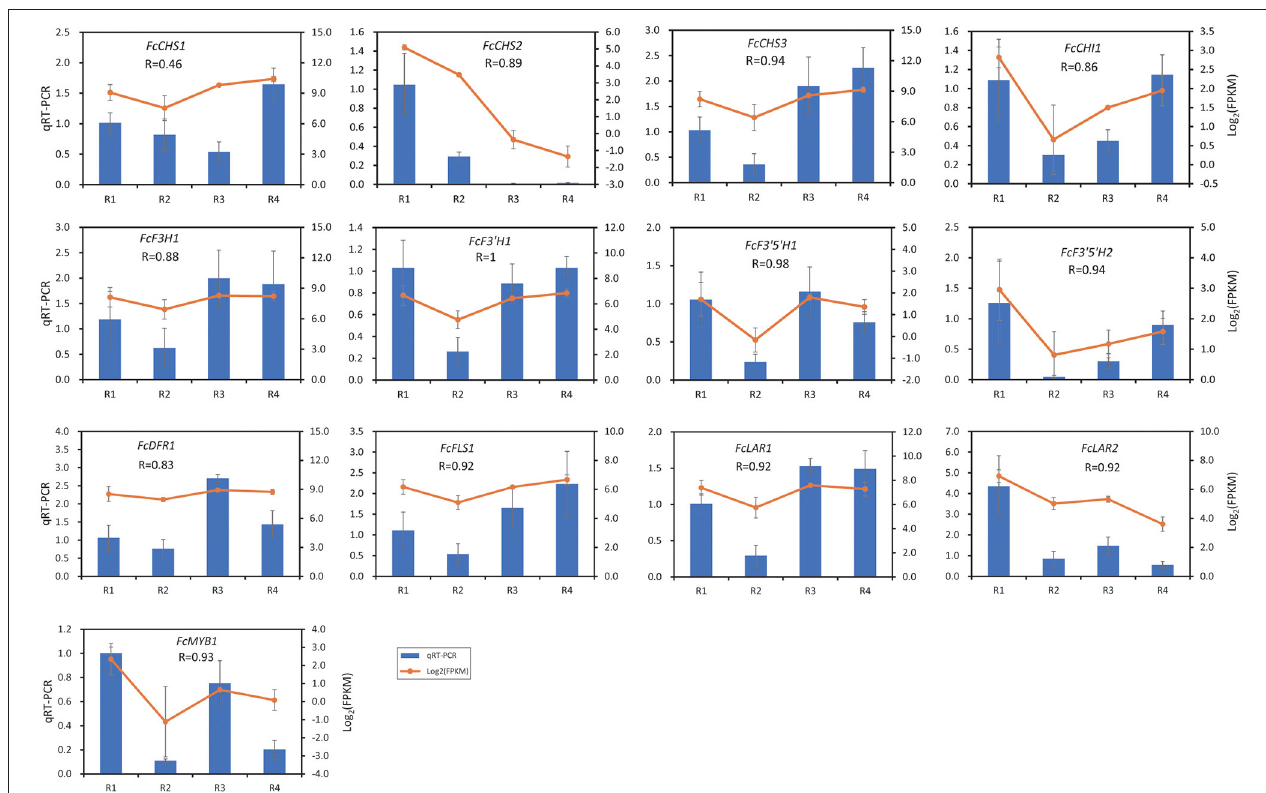
FIGURE 5 | Validation of gene expression by qRT-PCR analysis. The value of data is the average expression value of the transcriptome and qRT-PCR data. The error bar represents the standard deviation.